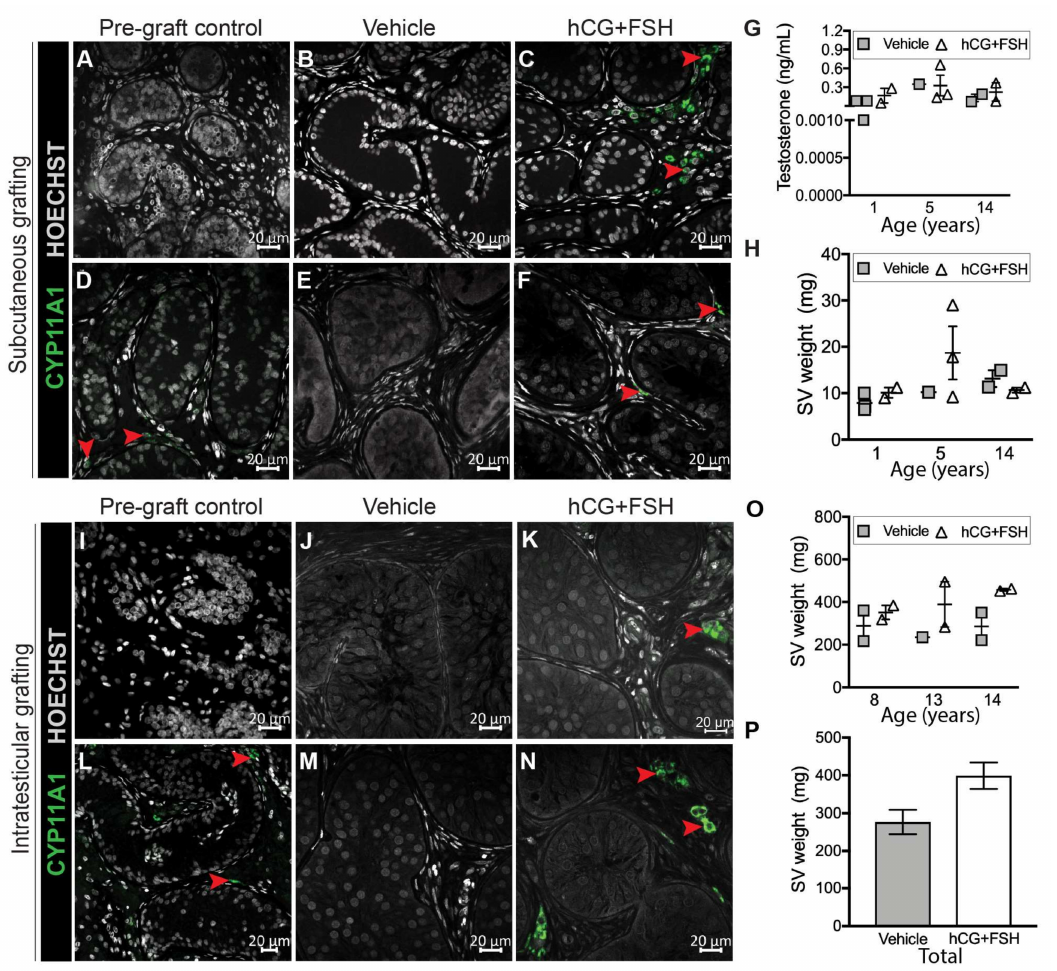
Figure 3. Steroidogenesis in prepubertal human testis xenografts. ( A – C ) Initiation of CYP11A1 expression in gonadotrophin-exposed subcutaneous xenografts (pre-graft control, 5-year-old). ( D – F ) Maintenance of CYP11A1 expression in gonadotrophin-exposed subcutaneous xenografts (pre-graft control, 1-year-old). ( G ) Plasma testosterone levels ( n = 6-7 mice per group; p = 0.594) and ( H ) seminal vesicle (SV) weights ( n = 6–7 mice per group; p = 0.431) in vehicle and gonadotrophin-exposed castrate host mice bearing subcutaneous xenografts. ( I – K ) Initiation of CYP11A1 expression in gonadotrophin-exposed intratesticular xenografts (pre-graft control, 8-year-old). ( L – N ) Maintenance of CYP11A1 expression in gonadotrophin-exposed intratesticular xenografts (pre-graft control, 14-year-old). ( O ) Seminal vesicle weight in vehicle and gonadotrophin-exposed intact host mice ( n = 5–6 mice per group; p = 0.076) bearing intratesticular xenografts. ( P ) Graph shows overall mean data. Statistical significance was determined using two-way ANOVA. Data are presented as mean ± SEM ( n = 3 prepubertal testis samples per transplantation site). Arrowheads indicate CYP11A1 +